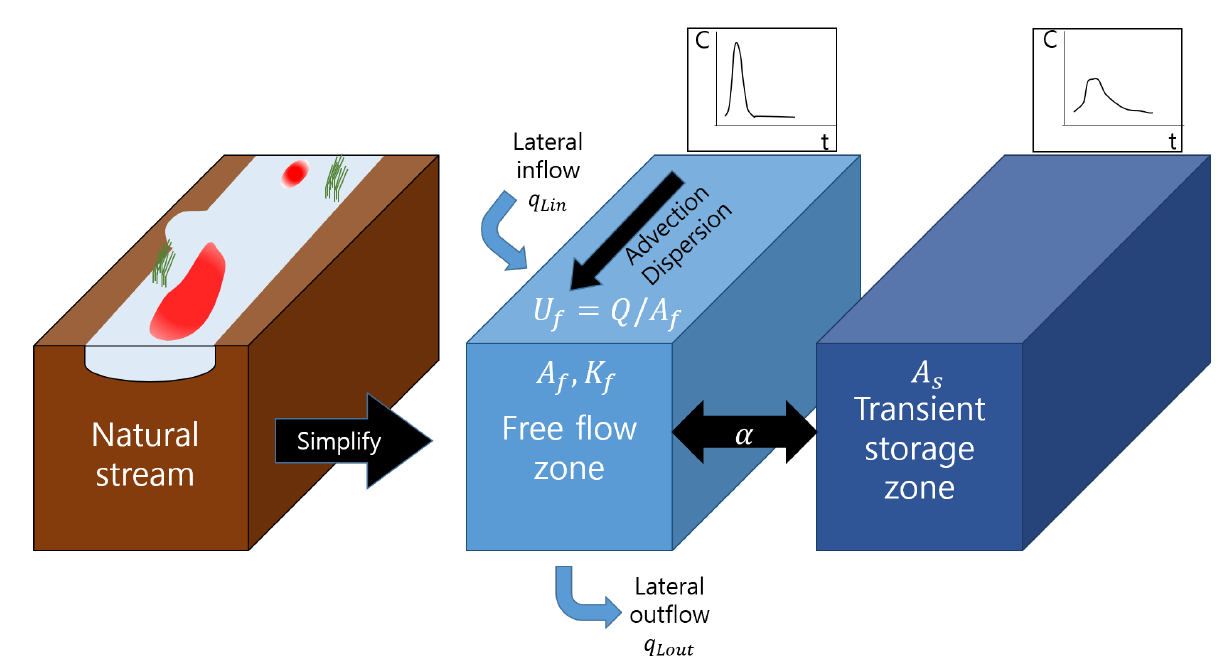
Figure 3. Conceptual diagram of TSM for conservative